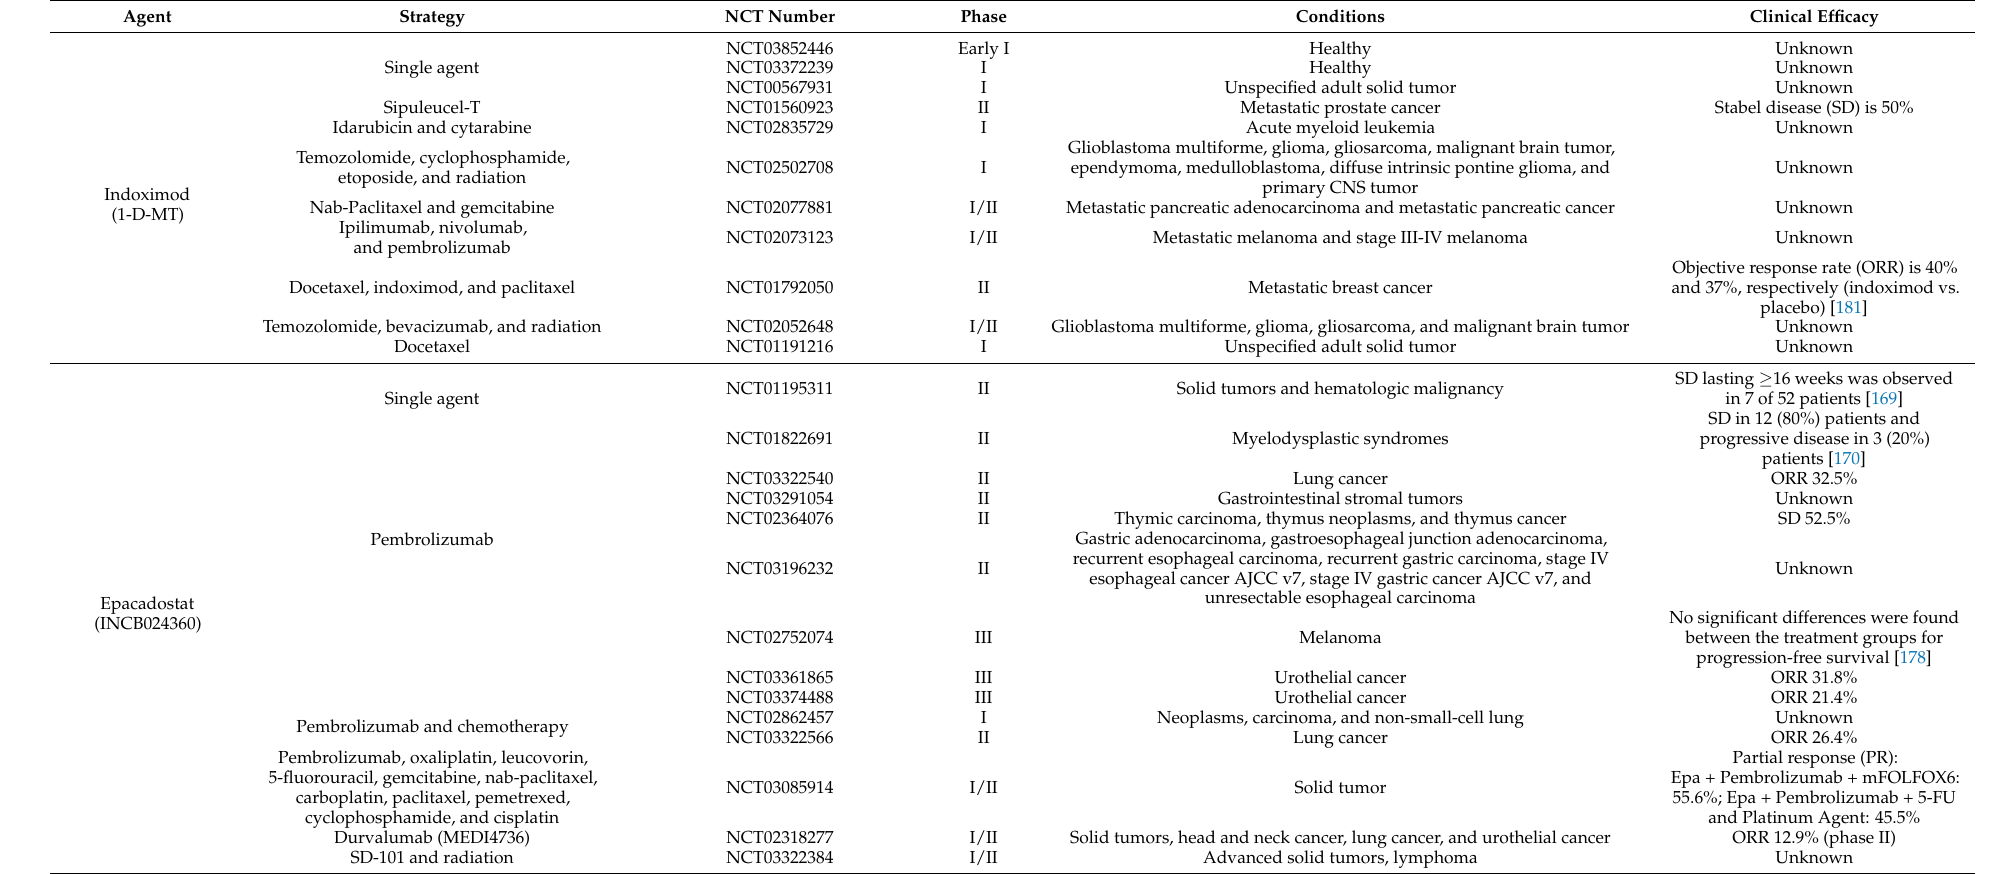
Table 2. IDO1 inhibitors as a single agent and in combination with other therapies in completed clinical